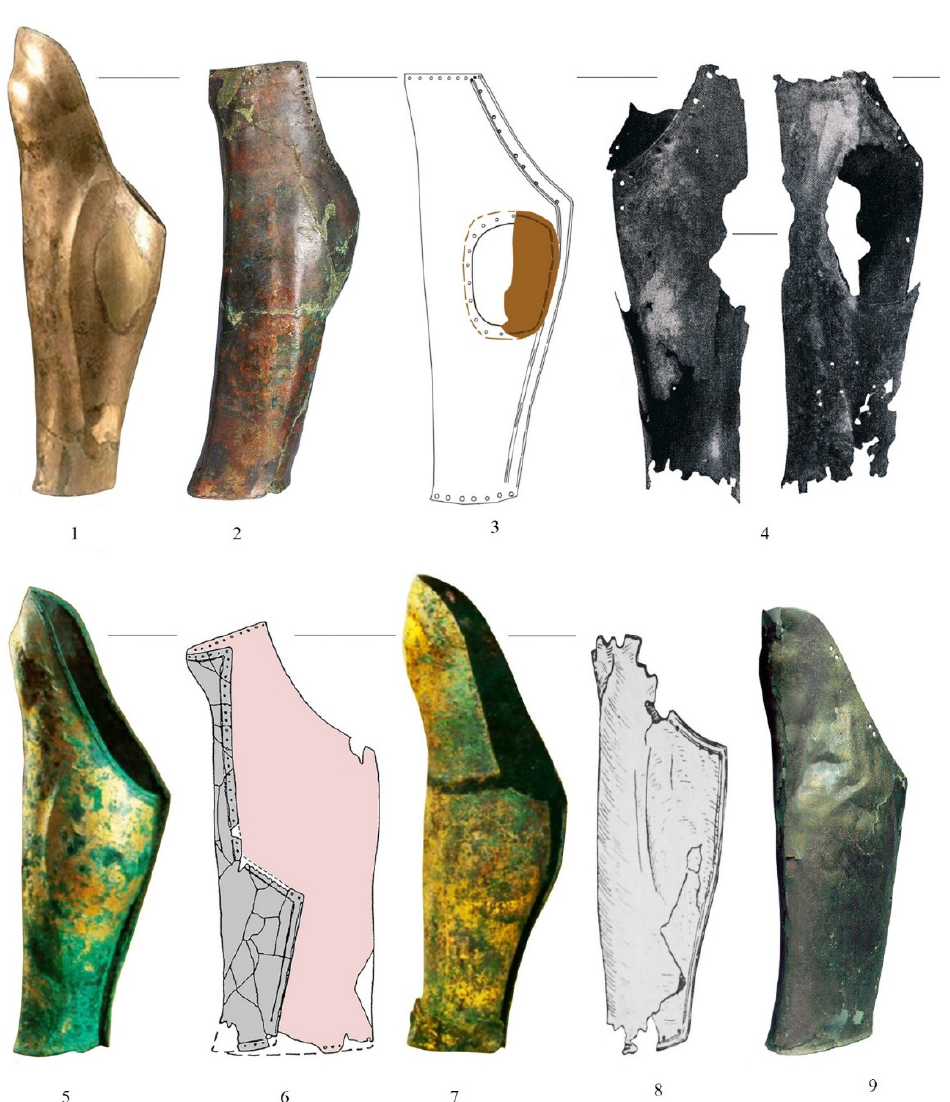
Figure 14. Variants of modifications of bronze greaves in the northern Black Sea area. 1, 5,